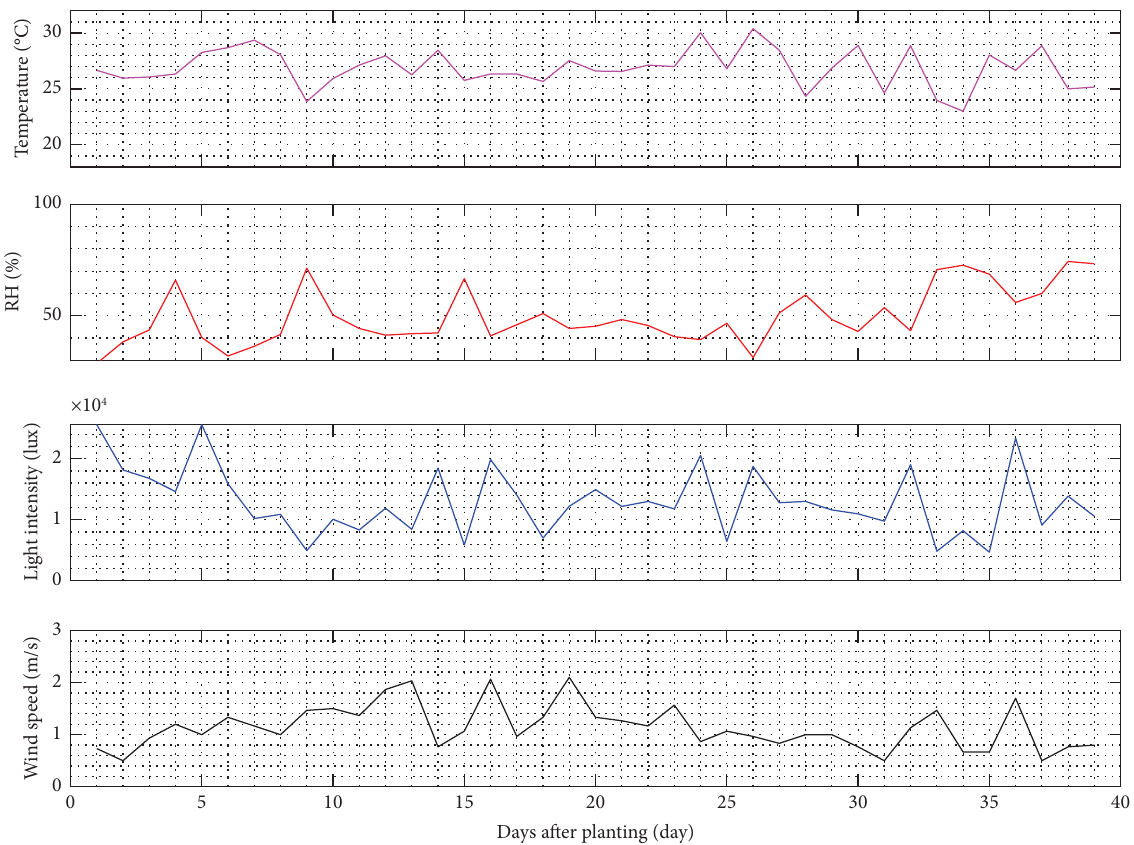
Figure 5: Microclimate conditions on the rooftop during pagoda mustard cultivation.